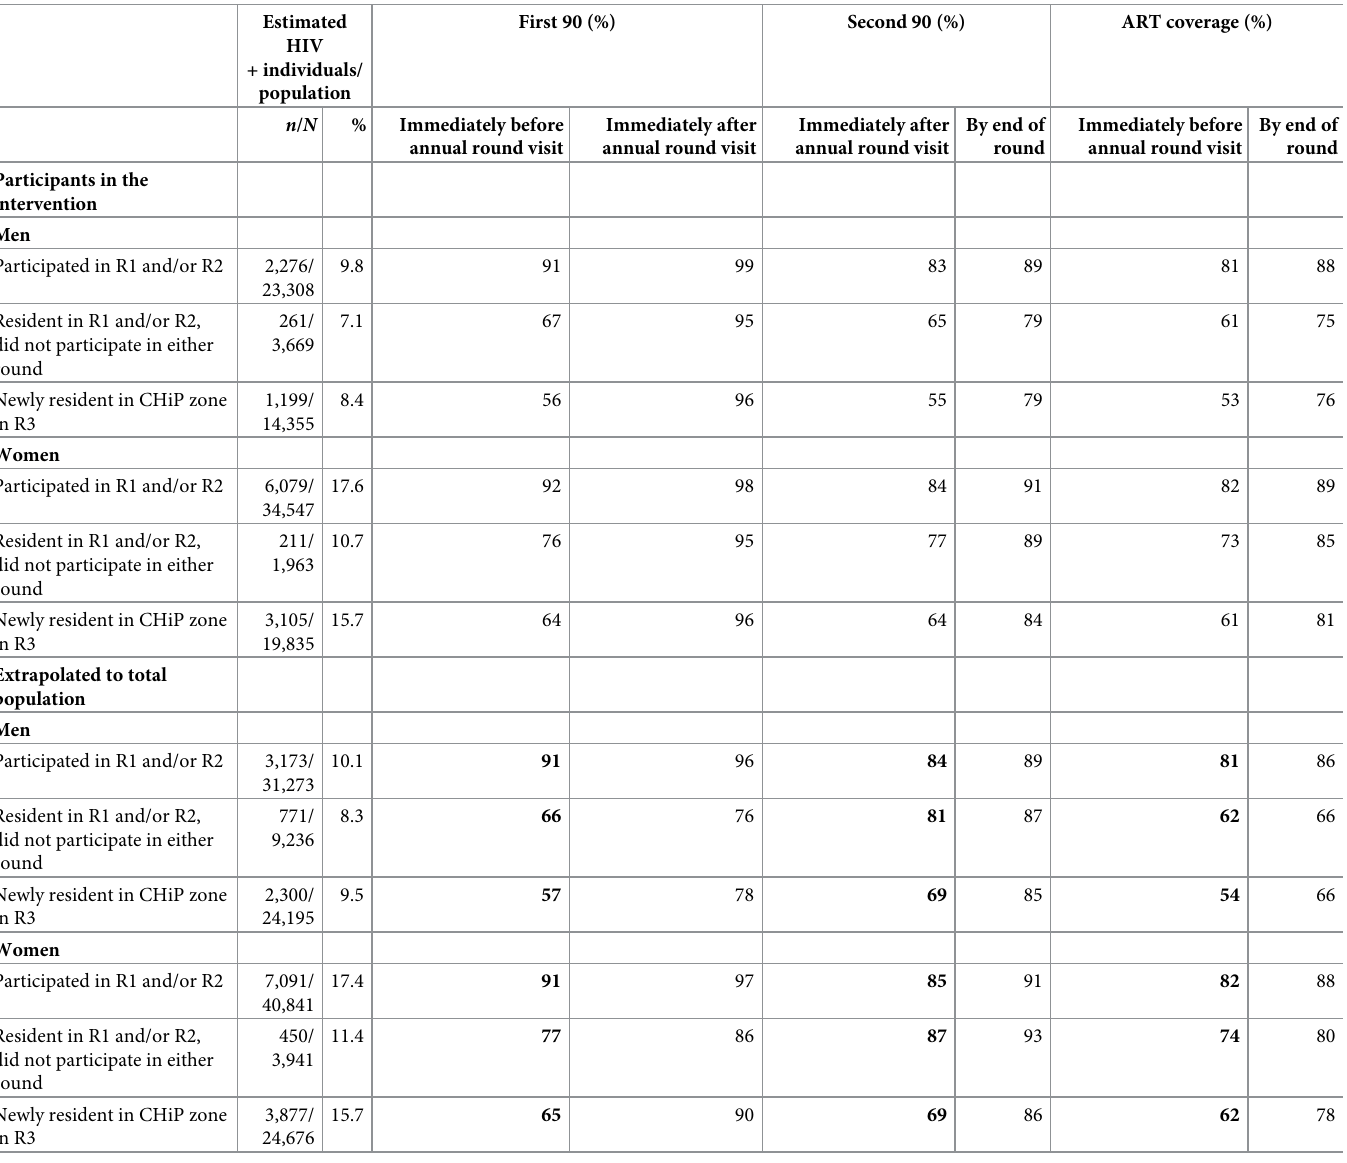
Table 3. Arm A, Zambian communities R3: Estimates of the percentage of HIV-positive individuals who knew their HIV-positive status (first 90), the percentage on ART among individuals who knew their HIV-positive status (second 90), and the percentage on ART among all HIV-positive individuals (ART coverage), by prior residency and prior participation in the intervention in